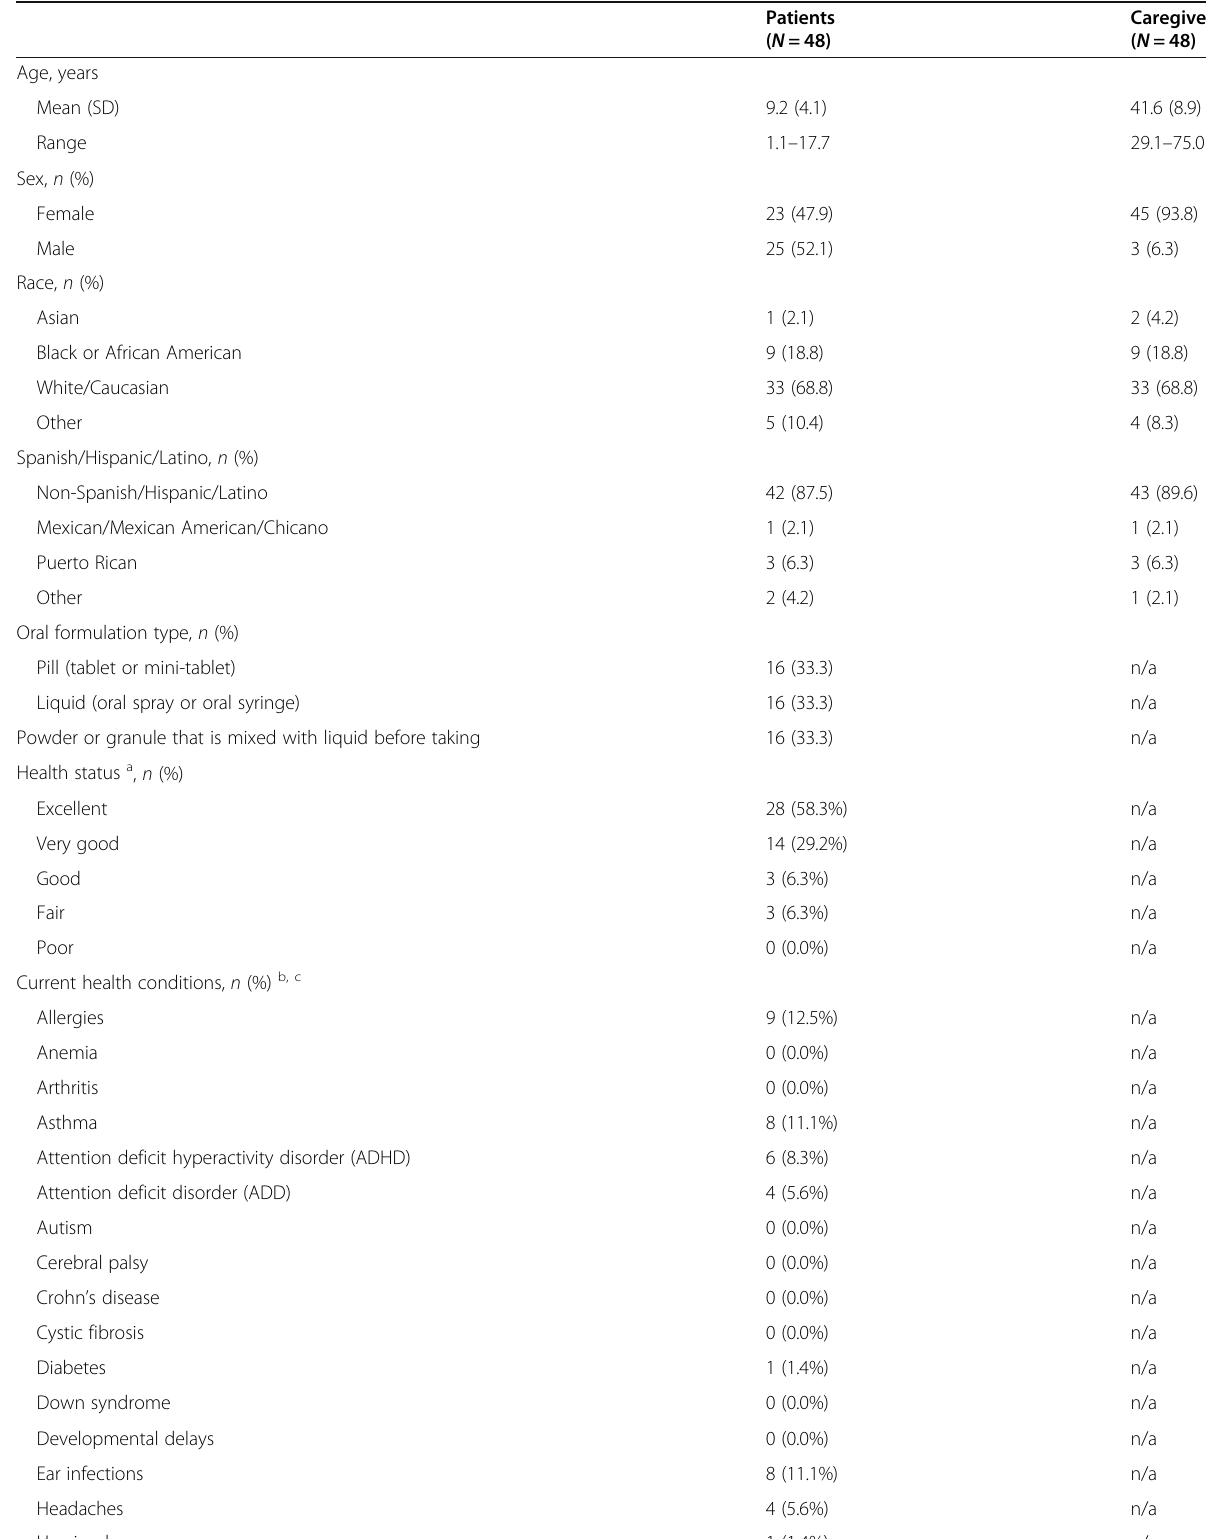
Table 2 Patient and caregiver demographic information and patient health